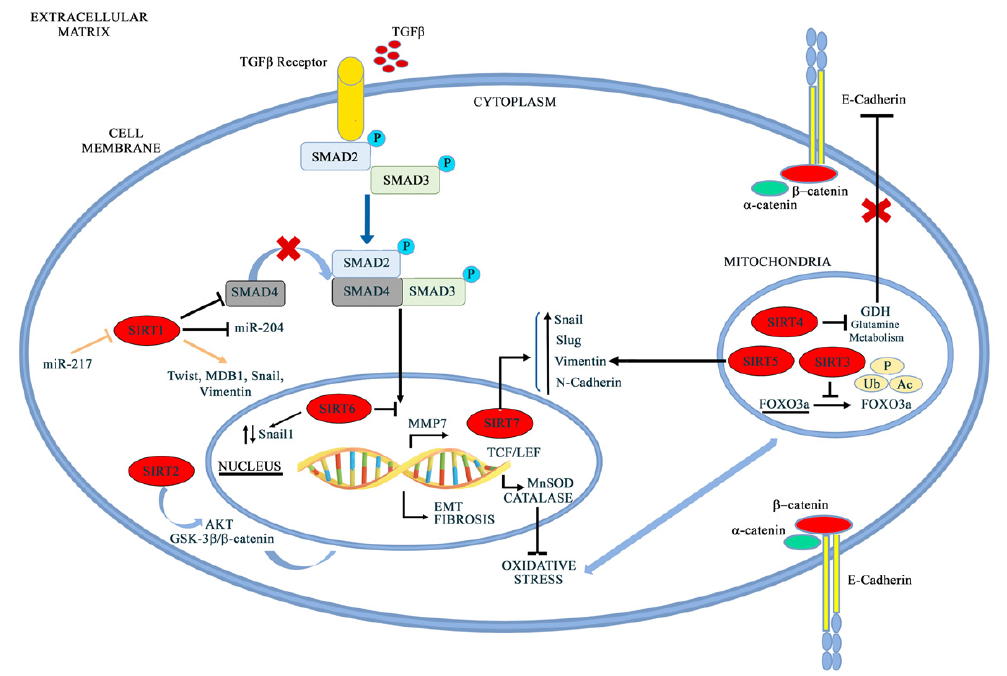
Figure 6. Schematic illustration of the molecular mechanisms of Sirtuins in regulating EMT. The scheme illustrates cytosolic (SIRT1 and SIRT2), nuclear (SIRT6 and SIRT7), and mitochondrial (SIRT3, SIRT4, and SIRT5) sirtuins. Some important sirtuins target involved in EMT are indicated, such as SMAD4, which is released upon SIRT1 downregulation, increasing nuclear accumulation of β -catenin and EMT induction. Similarly, SIRT2 increases nuclear β -catenin by deacetylating AKT. Nuclear sirtuins, such as SIRT6 and SIRT7, increase the activity of EMT transcription factors, such as Snail, Slug, and Vimentin. On the other hand, the role of mitochondrial sirtuins is still controversial, with some reports indicating the pro-EMT action of SIRT3 through an increase in β -catenin, while others have shown the anti-EMT action of SIRT3 through the repression of β -catenin and Twist1. Very little is known about SIRT4 and SIRT5, although they seem to prevent EMT